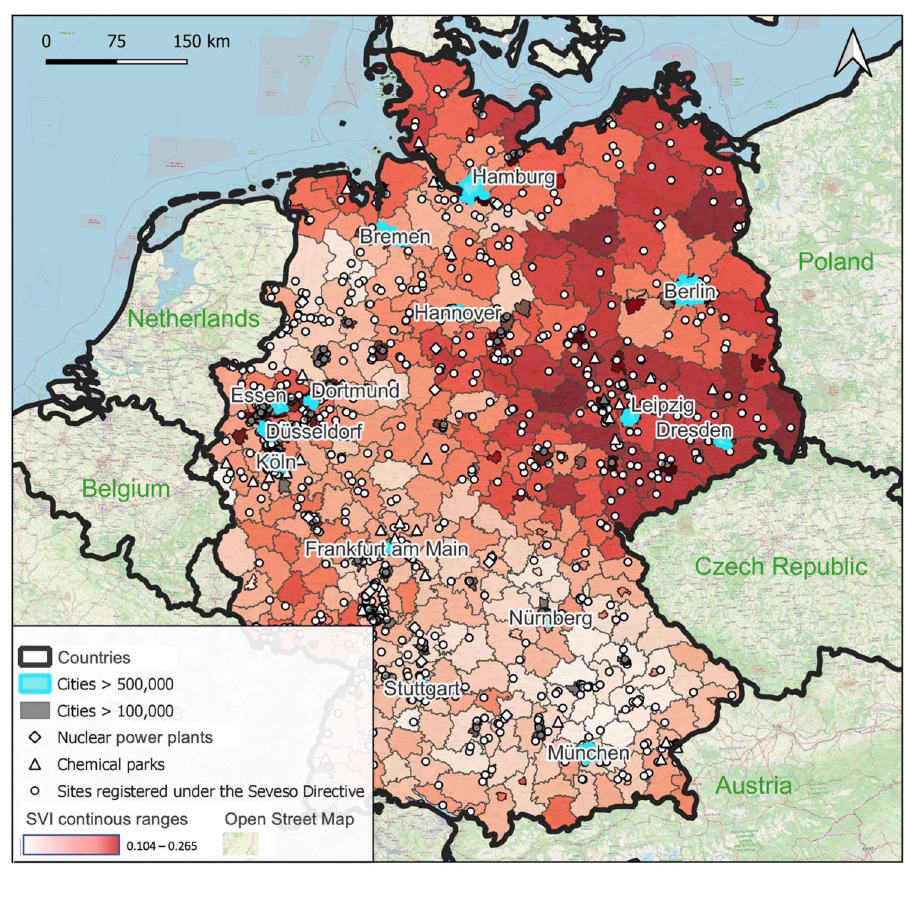
Fig. 3 Aggregated social vulnerability by county in Ger- many; and location of nuclear power plants (NPP), chemi- cal parks, and sites registered under the Seveso Directive in Germany. Data source Social